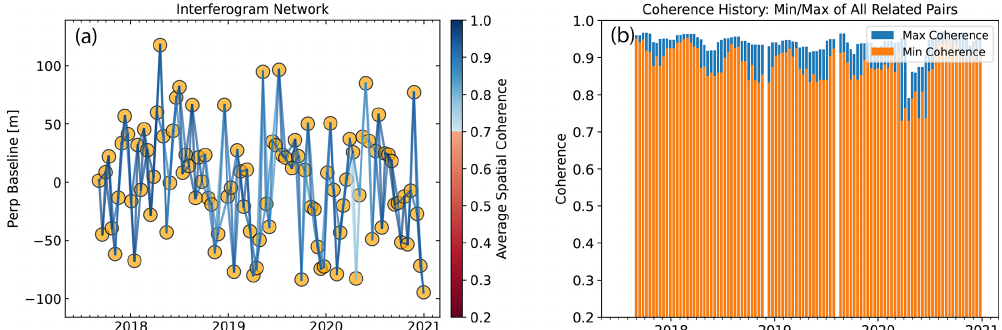
Figure A1. (a) Network of interferograms for deformation time series estimation, color-coded by average coherence of the interferograms. Circles represent the acquisition dates, and lines represent the interferograms. (b) Average coherence of all related pairs for each SAR acquisition date. “Perp” denotes perpendicular; “Ifgram” denotes